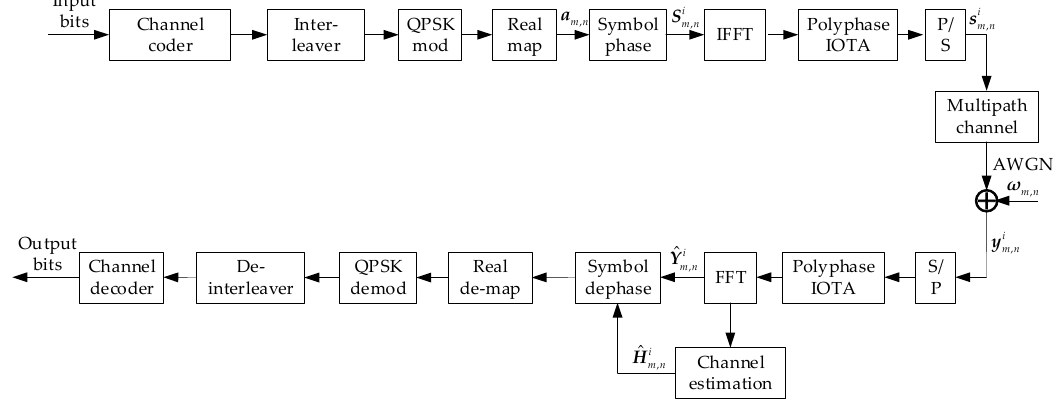
Figure 3. OFDM-IOTA system model. AWGN: additive white Gaussian noise; FFT: fast Fourier transform; IFFT: inverse FFT.